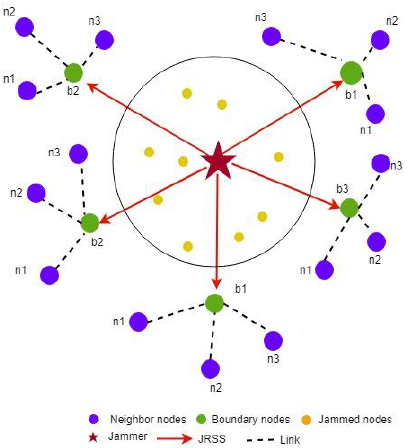
Figure 4. JRSS received by selected boundary nodes.